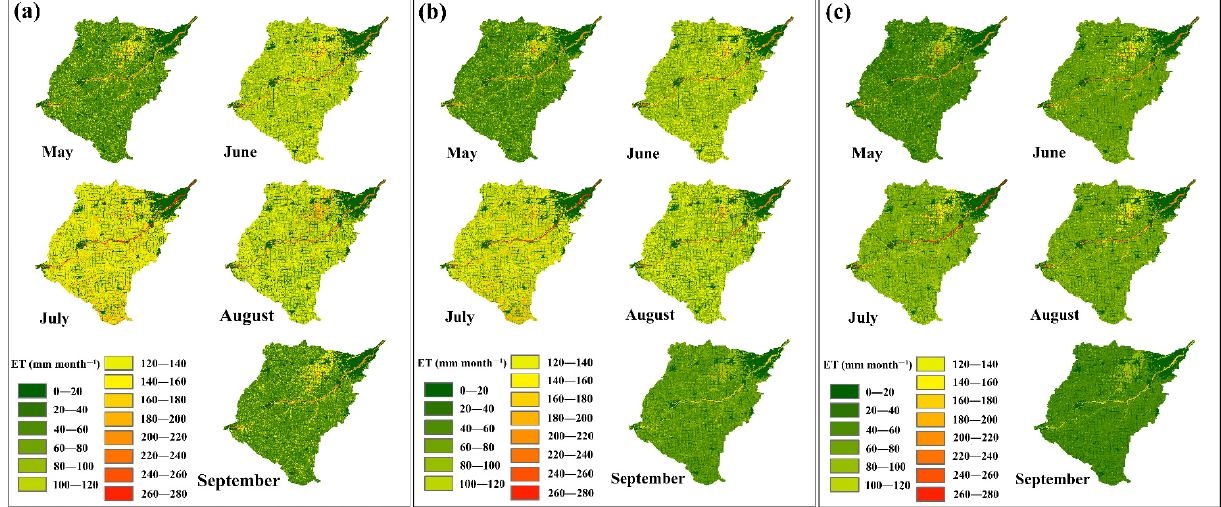
Figure 7. Monthly ET rates simulated by BEPS during the 2018 growing season under three scenarios of stomatal conductance values: ( a ) High stomatal conductance, ( b ) Middle stomatal conductance, and ( c ) Low stomatal conductance. Table 7. Comparison between the average daily BEPS- and ECOSTRESS-derived ET rates over the study site in August 2018. SC—Stomatal conductance; sd—standard